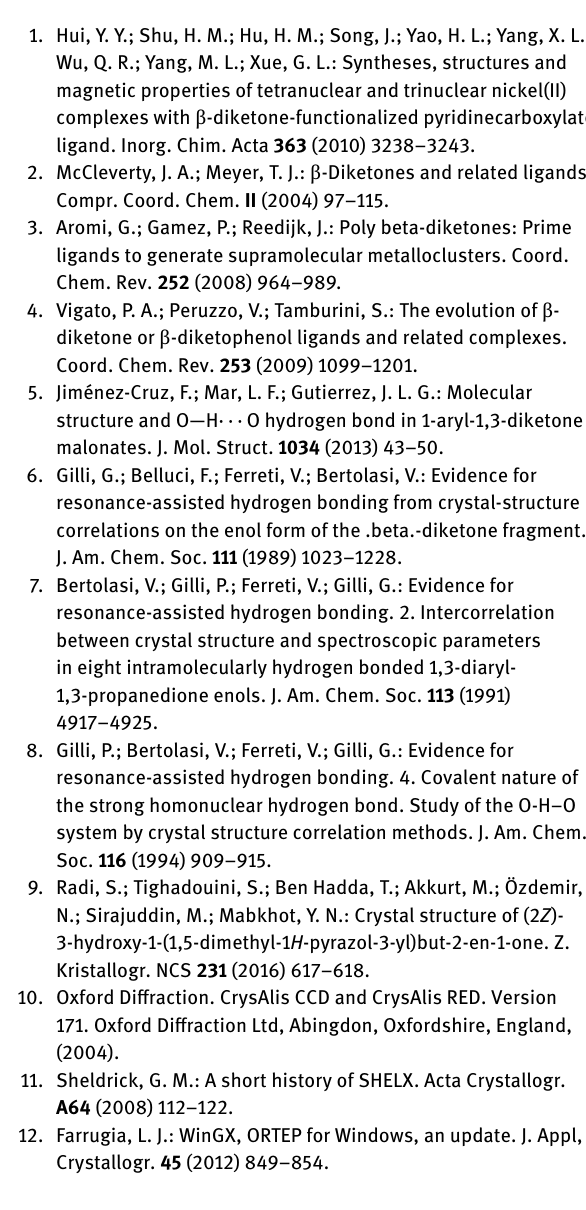
balancingtheintra-electrostaticforces.Thetwooxygenatoms O1, O2 are separated by a distance of 2.5104(6) Å. Further- more, the N1—N2 distance (1.3454(6) Å) is in good agreement with the lengths of bonds reported for analogous compounds [9]. N1, N2, C4, C5, and C6 atoms are in the same plane with a r.m.s. deviation of 0.0038 Å. The torsion angle O2—C3—C4— N2 of 170.12(6)° indicates that the pyrazolyl moiety undergoes slight inclination with respect to the plane discussed